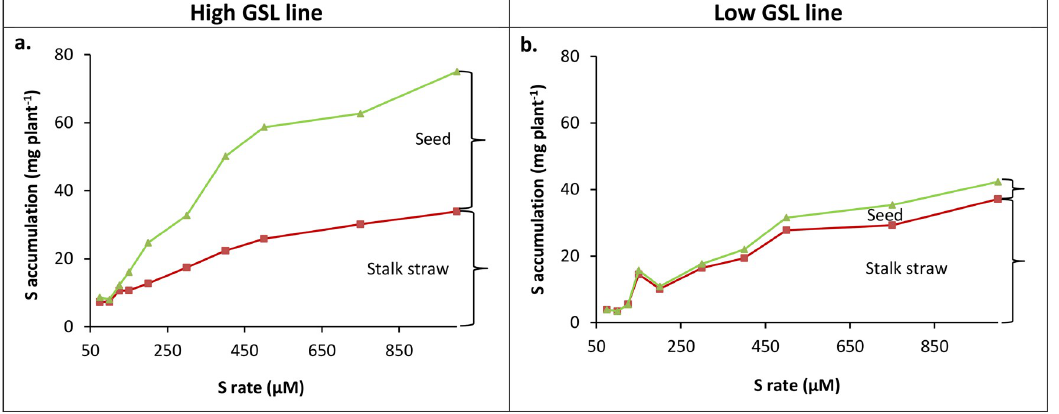
Fig 2. Effect of sulfur supply on partitioning of sulfur between seed and stalk straw. (a) the high-GSL line and (b) the low-GSL line. Combined S (mg plant -1 ) accumulation of seed and stalk straw are shown by green lines and only stalk straw are shown by red